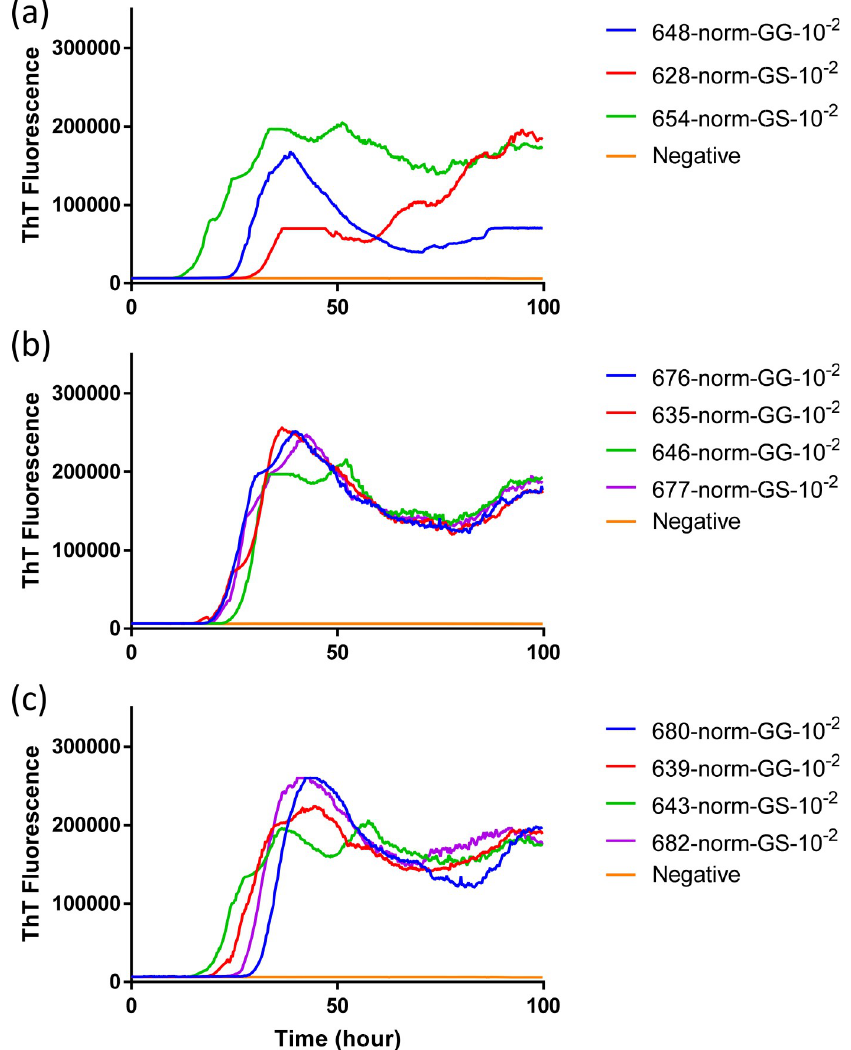
Fig 4. Comparison of seeding activity of RT-QuIC reactions with human rPrP which contain brain seeds from WTD inoculated with infected brains from WTD (a), elk (b) or mule deer (c). This shows RT-QuIC reactions seeded with 10 − 2 dilution of EIA normalized brains in the presence of 0.002% SDS. Data are presented as mean ThT fluorescence of 4 repeated reactions. Data are presented as mean ThT fluorescence of 4 repeated reactions.